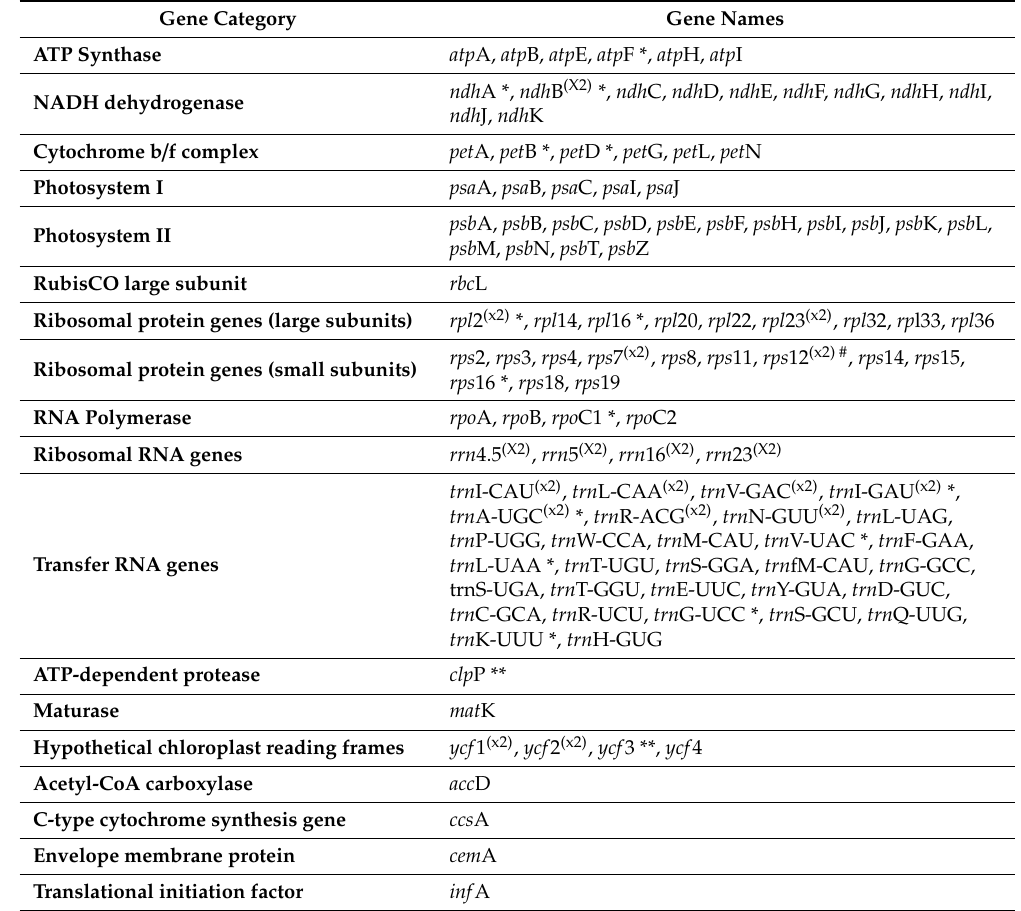
Table 2. List of genes encoded by six Bougainvillea cp